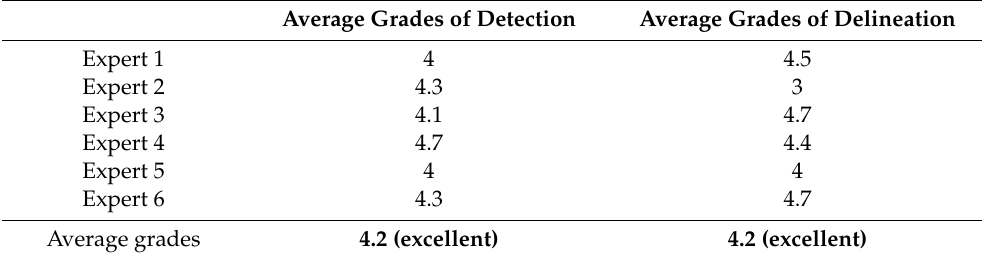
Table 7. Results from the expert-based qualitative assessment on a Mask R-CNN model (trained only on VHSR fixed-wing aircraft imagery) in mapping ice-wedge polygons from a 0.15 m resolution UAV image, Arctic Coastal Plain, northern